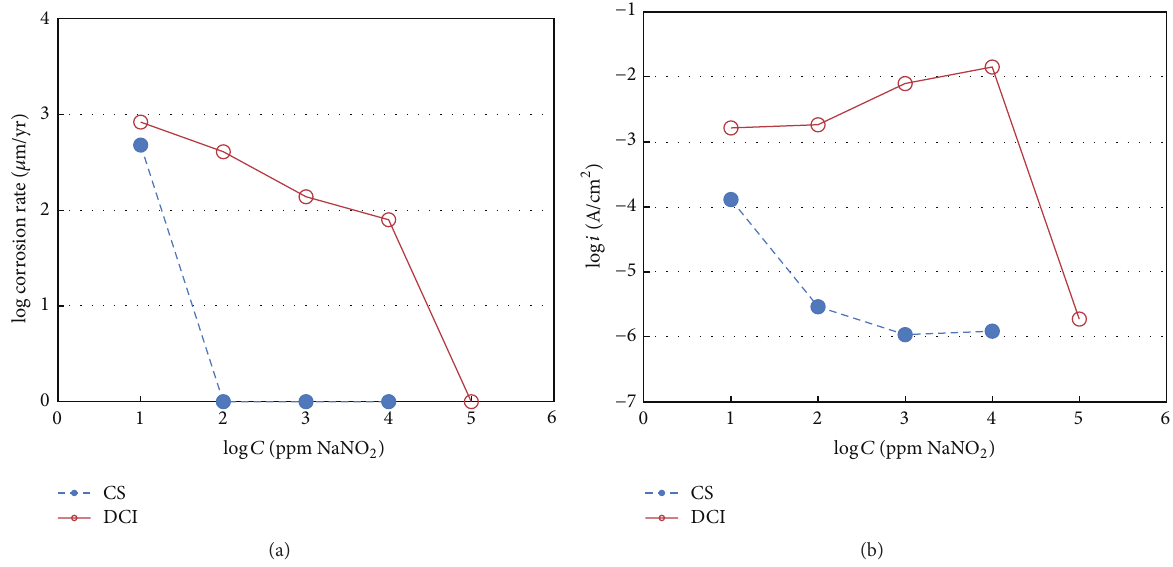
Figure 4: Comparison of (a) corrosion rate (circulation condition) from Figure 1 and (b) current density obtained at +400 mV (SCE) of Figure 3 by NaNO 2 addition to simulated cooling water.